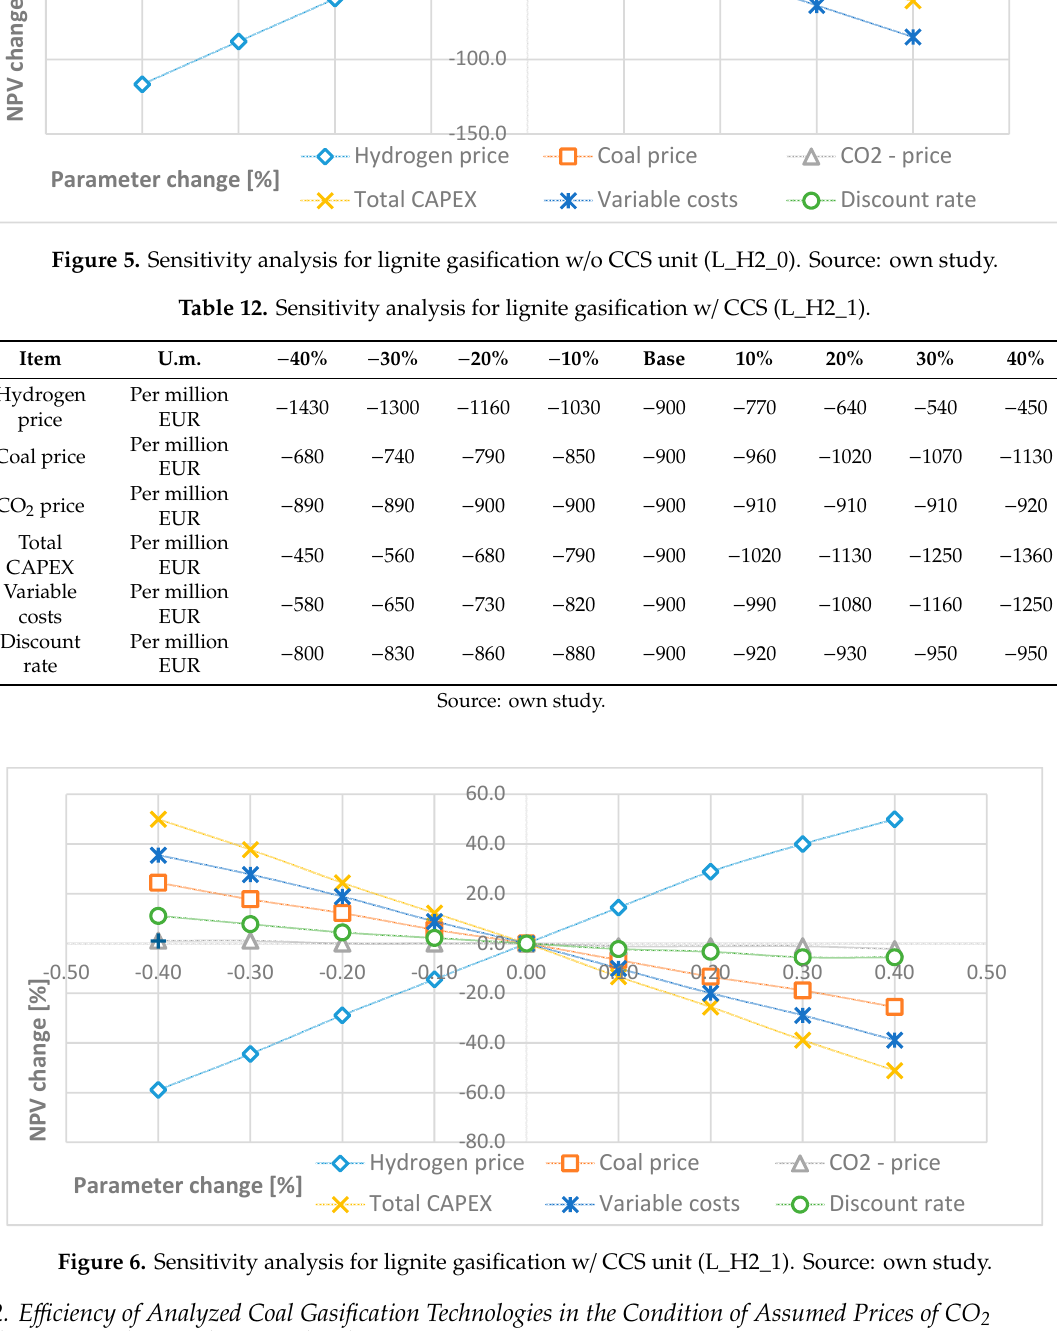
Figure 6. Sensitivity analysis for lignite gasification w/ CCS unit (L_H2_1). Source: own study.